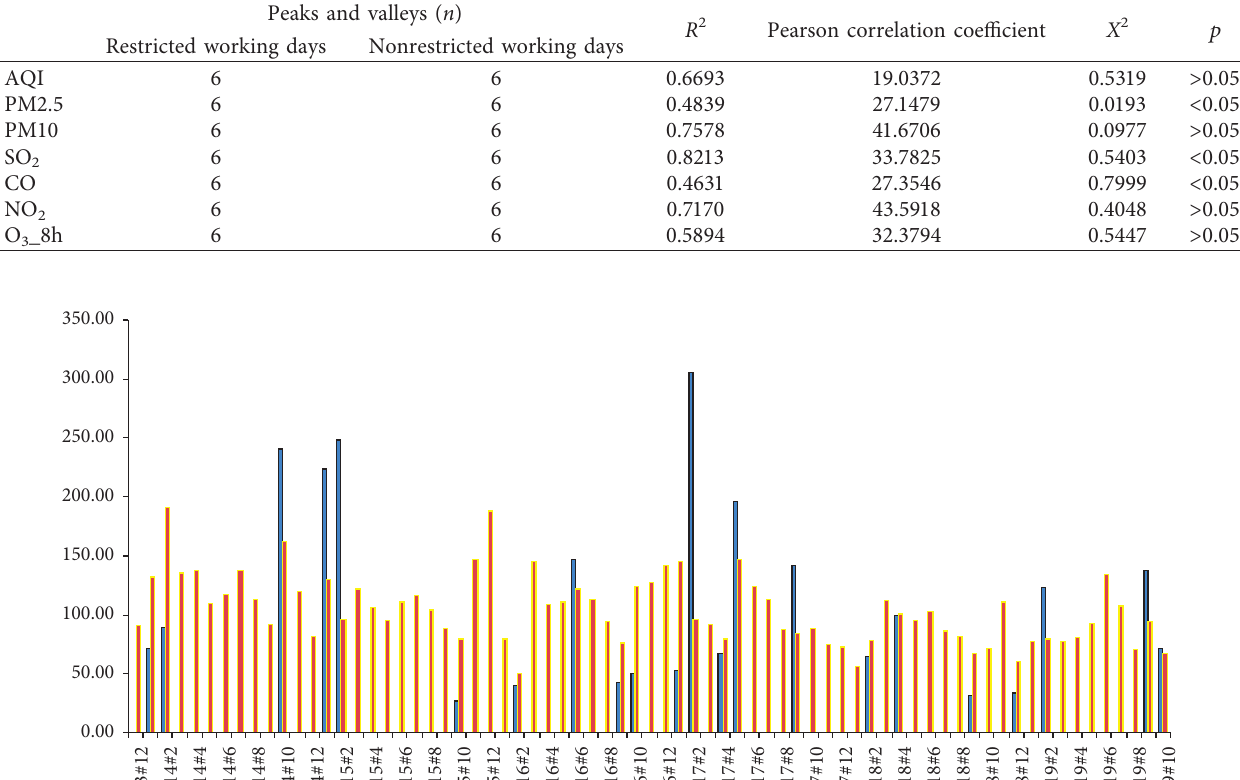
Table 4: Pearson correlation analysis of restricted working days and nonrestricted working